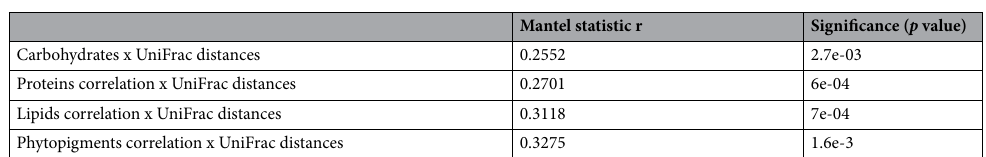
Table 1. Output of Mantel test analyses on the Spearman correlation of the unweighted UniFrac distances of microbiome structure and distance matrix of biochemical components generated with dist function in R (method = “ Euclidean ”), number of permutations: